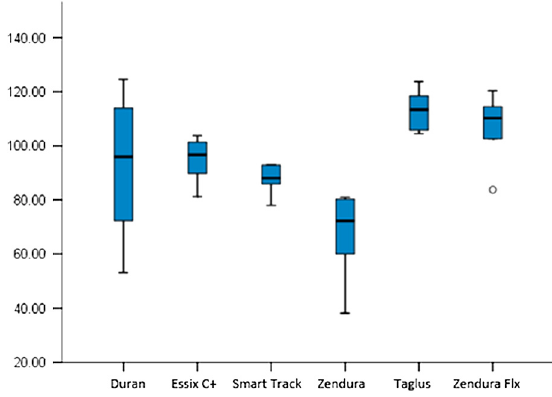
* p indicates the differences between groups. **Post-hoc binary group comparisons according to Dunn-Bonferroni test: a—Differences between Duran, b—Differences between Essix C+, c—Differences between Smart Track, d—Differences between Zendura, e—Differences between